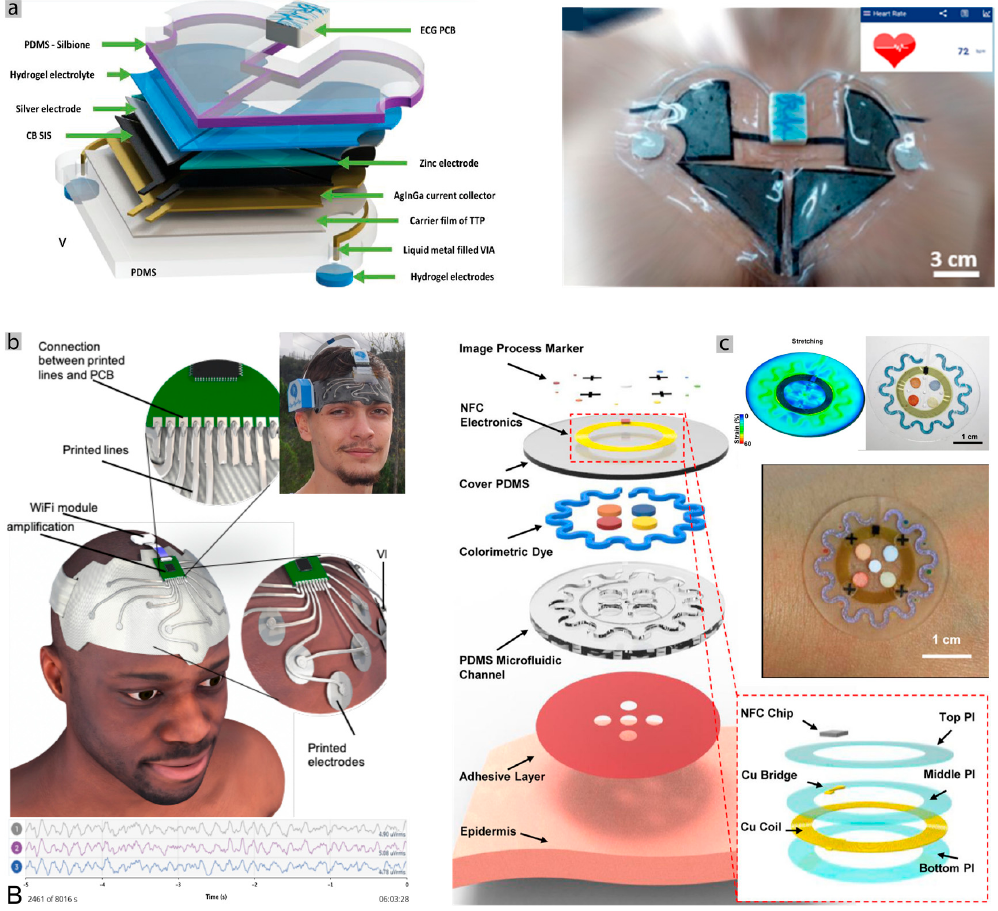
Figure 4. Examples of different wearables conformal to the skin. ( a ) Fully untethered electrocardiogram (ECG) patch with integrated stretchable printed Ag–Zinc battery able to work for 6 days. Adapted with permission from [88]. ( b ) Comfortable and affordable e-textile headband for electroencephalogram (EEG) acquisition. It is possible to be worn for extended periods of time, as can be seen in the EEG signal captured during sleep. Adapted with permission from [112]. ( c ) Adhesive colorimetric sensor of sweat. It has a microfluidic system for sweat capture and chemical analysis for different factors. Furthermore, it has Near Field Communication (NFC) communication without a battery. Adapted with permission from [113].